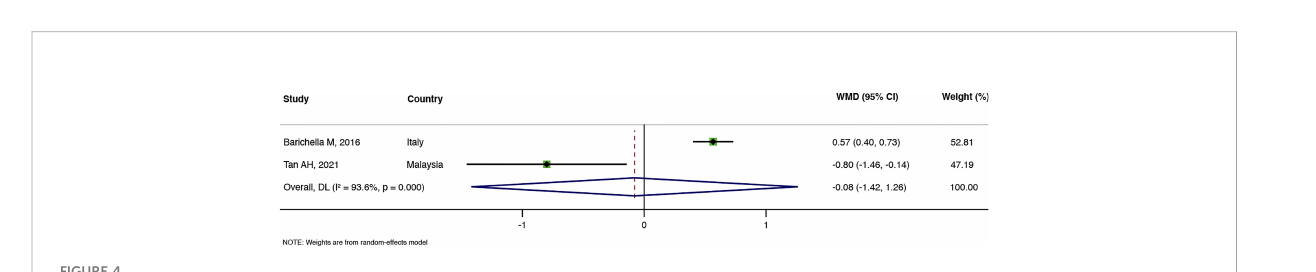
FIGURE 4 Meta-analysis of average stool consistency.